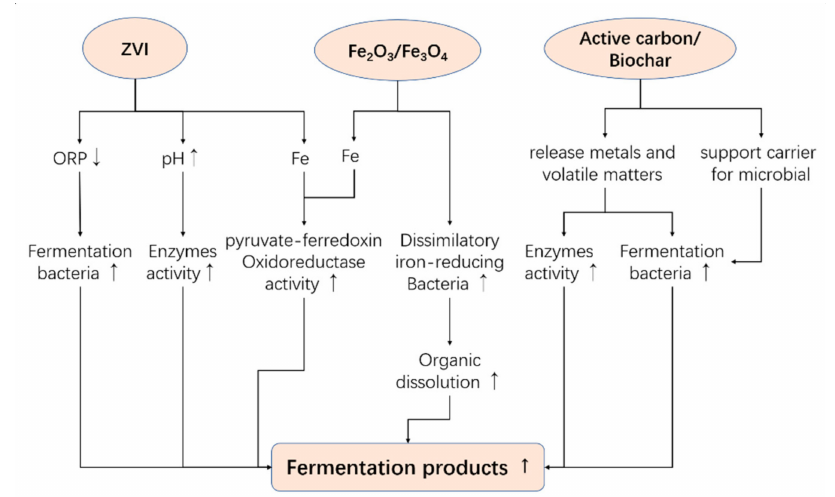
Figure 4. Main mechanisms of iron-based materials and carbon-based materials in FW